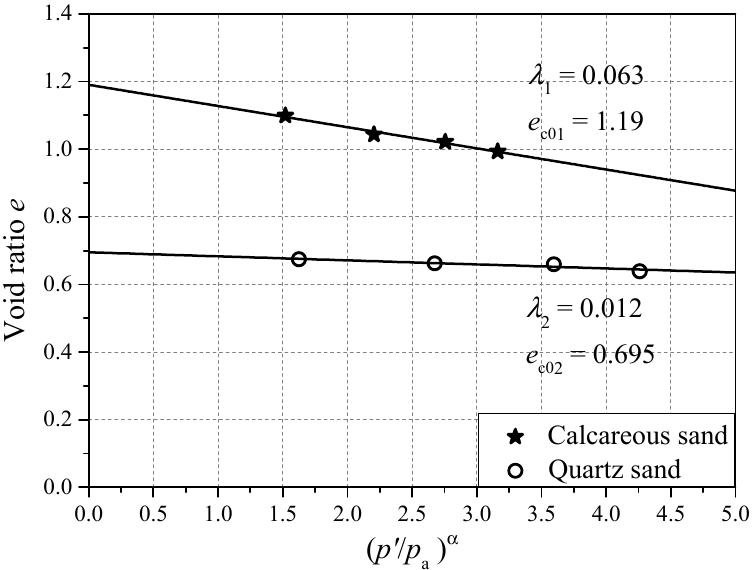
Figure 6. The critical state lines in the e –( p ′ / p a ) α plane of the calcareous sand and quartz sand ( D m = 2.667).